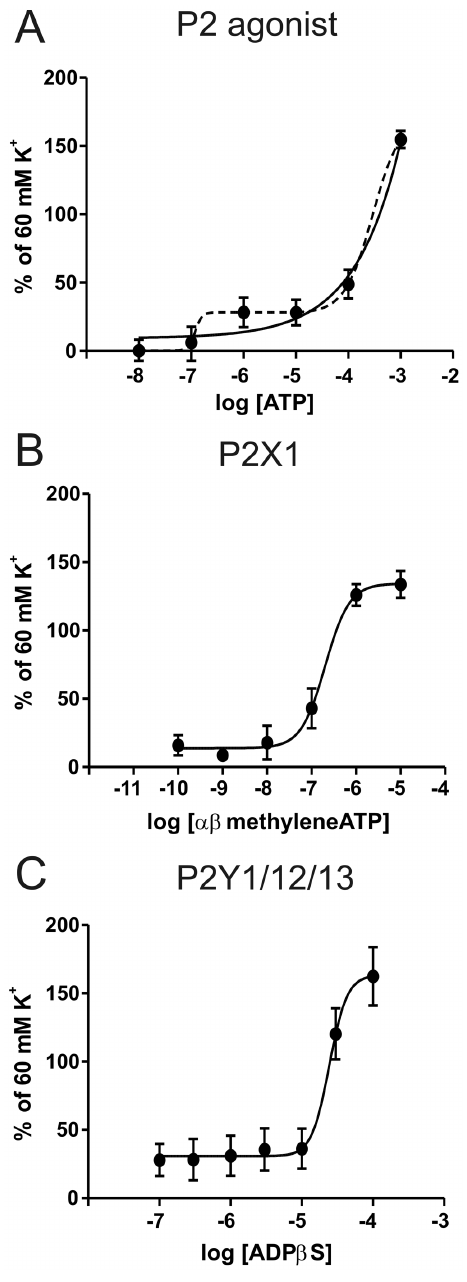
Figure 3. Contractile response to purine nucleotides. A) Response to ATP could be interpreted as either biphasic (stapled line) or sigmoidal (full line). The dose response is made in the presence of SCH580261 (A2A antagonist), to prevent relaxation by the produced adenosine. B) Response to ab metATP, a P2X1 agonist. The response curve was created using 100 fold increments in the dose response curve to avoid desensitisation. C) Contraction in response to ADP b S, a stable ADP analogue and P2Y1/12/13 agonist.